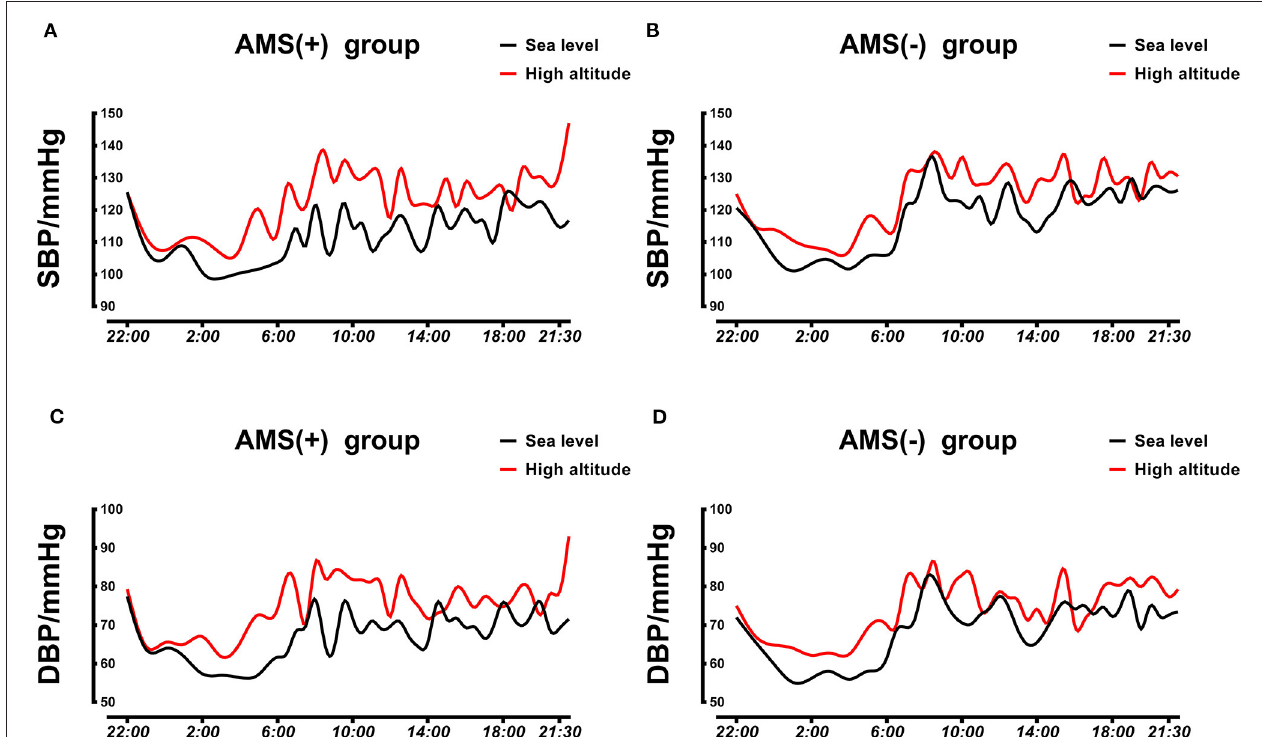
FIGURE 3 | Averaged 24-h SBP and DBP profiles in AMS and non-AMS subjects. (A) Averaged 24-h SBP in AMS subjects at LA and HA. (B) Averaged 24-h SBP in non-AMS subjects at LA and HA. (C) Averaged 24-h DBP in AMS subjects at LA and HA. (D) Averaged 24-h DBP in non-AMS subjects at LA and HA. SBP, systolic blood pressure; DBP, diastolic blood pressure; LA, low altitude; HA, high altitude; AMS, acute mountain